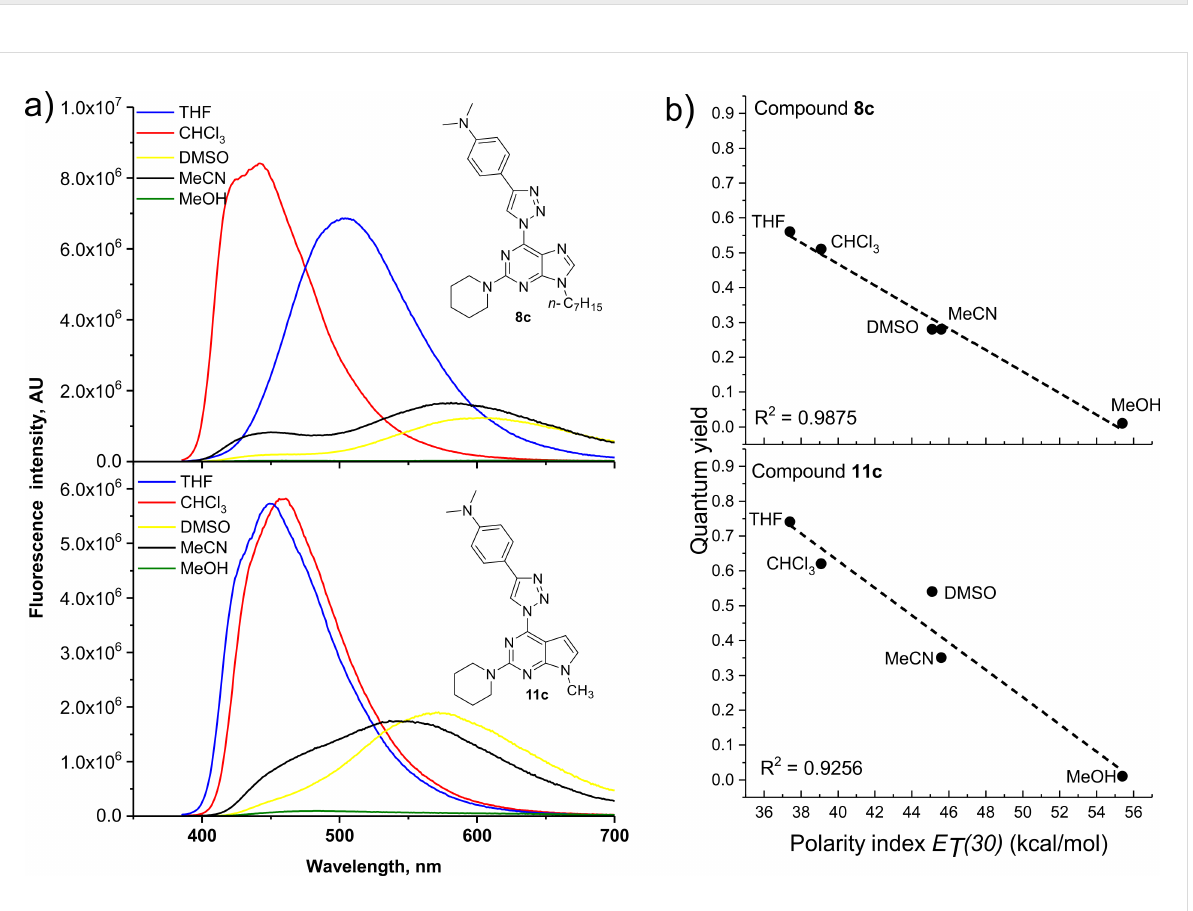
Figure 6: a) Fluorescence spectra of compounds 8c ( λ exc = 360 nm) and 11c ( λ exc = 370 nm) in solvents of different polarity, c = 10 − 4 M. b) Quan- tum yield dependence on the Dimroth–Reichardt polarity parameter E T (30) with a linear fit for compounds 8c and 11c